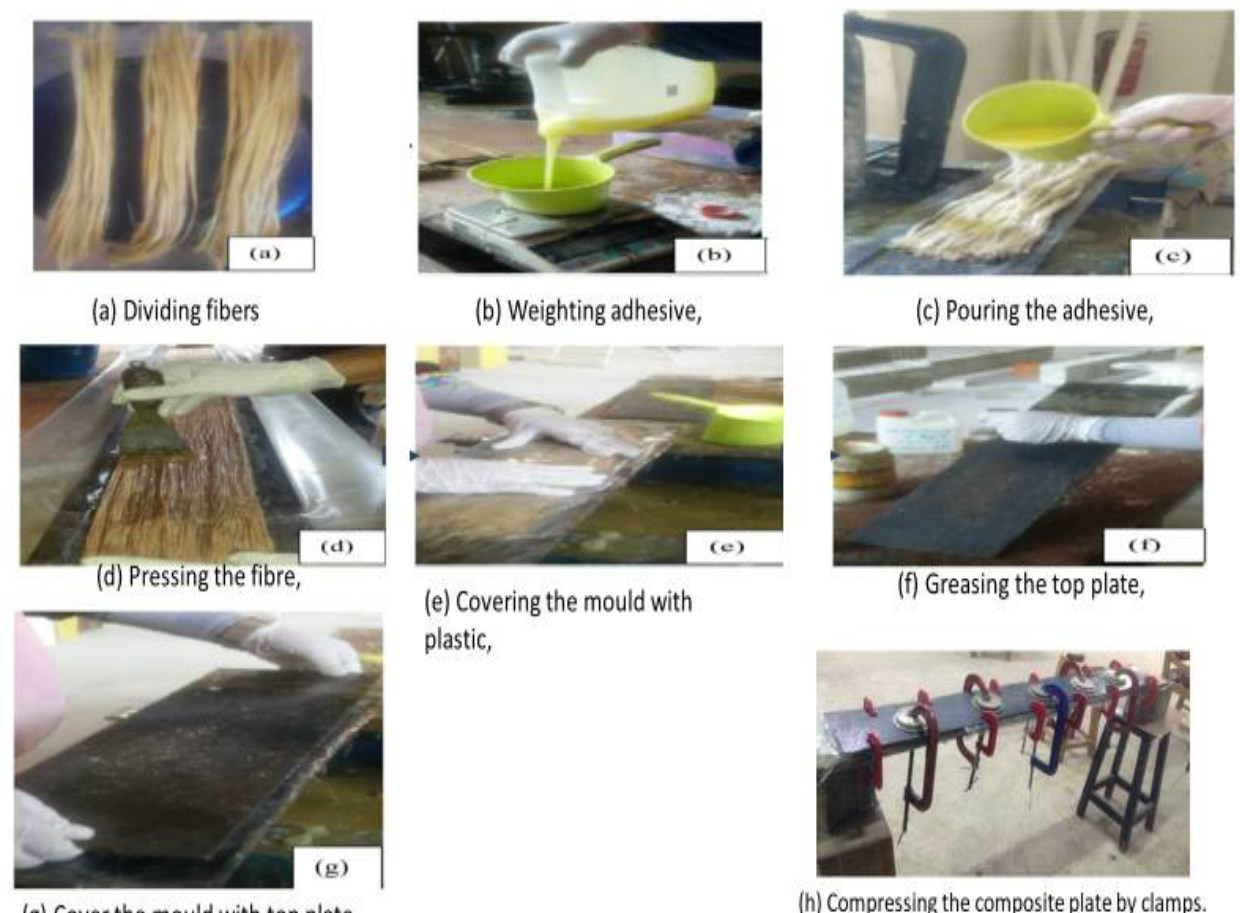
Figure 1. Process of fabricating bamboo fiber laminate.